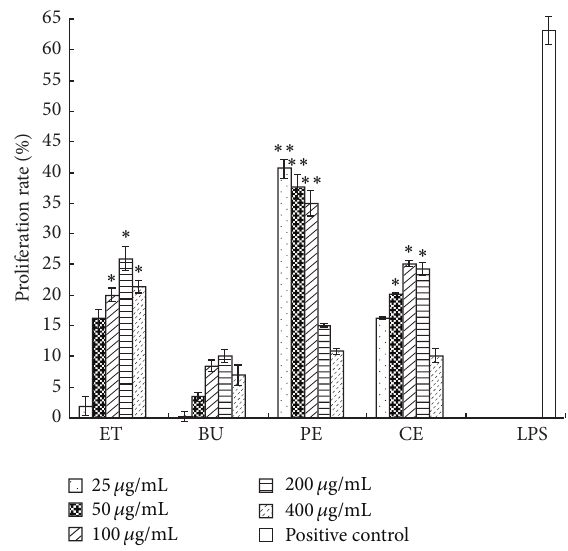
Figure 1: Effects of extracts on the proliferation of the mouse splenocytes. ∗ 𝑃 < 0.05 and ∗∗ 𝑃 < 0.01 compared with the control.